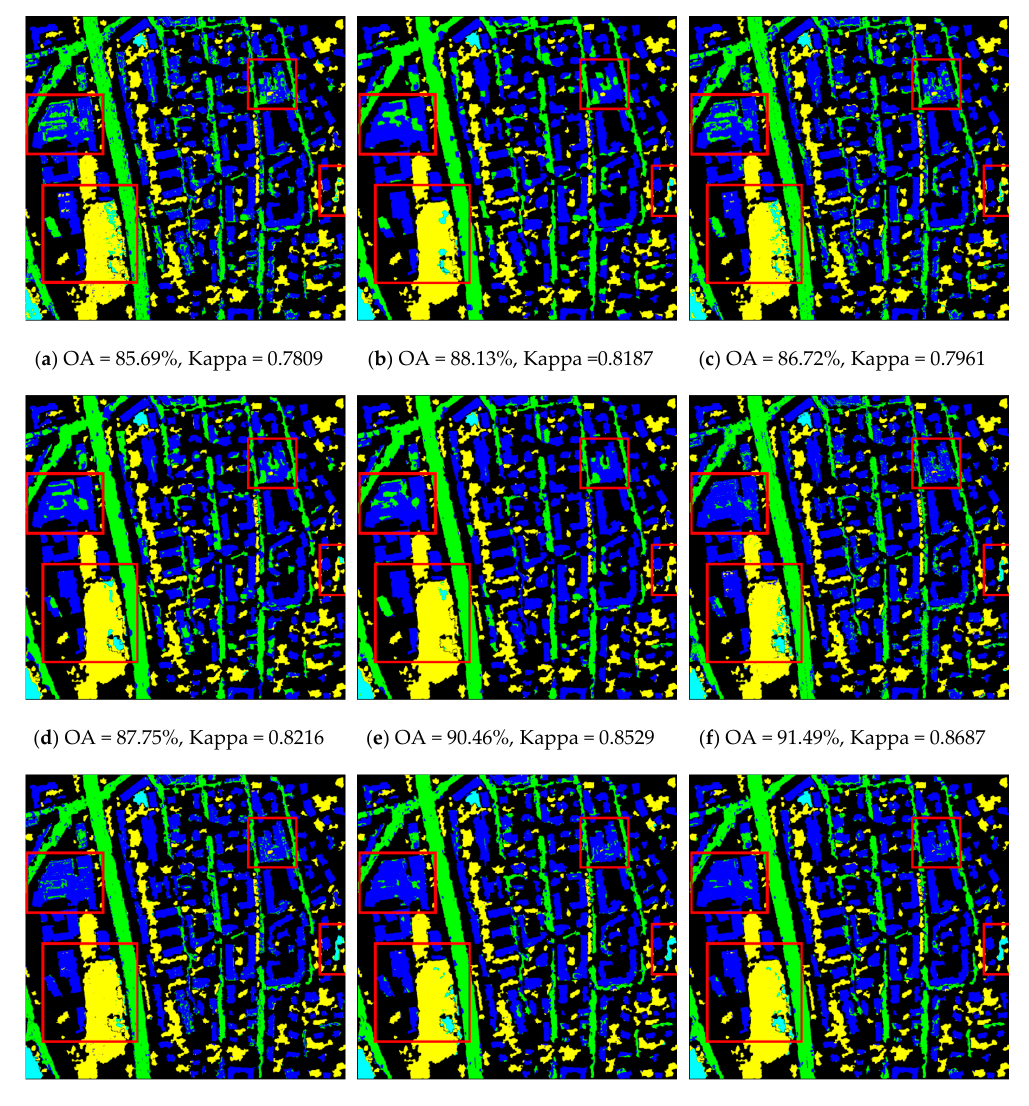
Figure 14. Classification maps obtained by: ( a ) original bands; ( b ) SLIC Raw (when S = 15); ( c ) PGF (with r = 2); ( d ) SGF (with r = 7); ( e ) GF Prob (with r = 14); ( f ) MPGF (with r = [1,30]); ( g ) extended morphological profiles (EMPs) (with r = [1,30]); ( h ) the proposed MSGF (with r = [1,30]); ( i ) the proposed FS-MSGF (with r = [1,30] and F = 40) (Zh1).